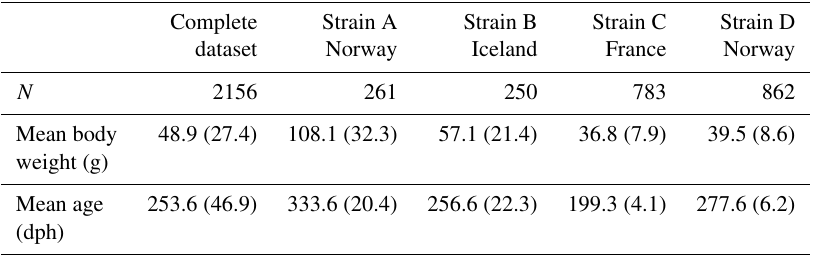
Table 1. Numbers, mean weights, and ages of animals at the start of the growth experiment for the complete dataset and for separate strains. N : number of animals; dph: age in days post-hatch; standard deviations are given in